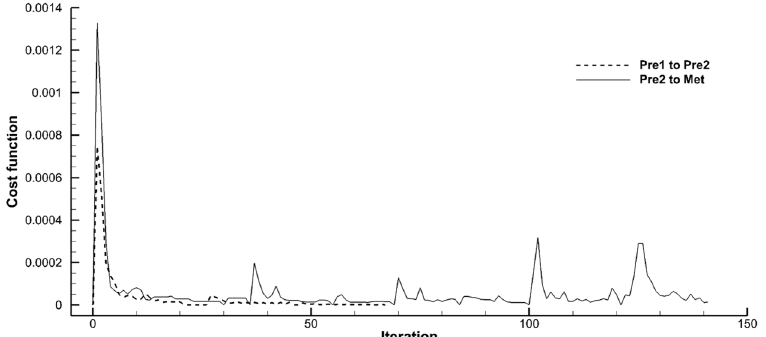
Fig 7. Convergence of cost function during image registration of pre-metastatic and metastatic pairs of a sarcomapatient (Group 3) shown in Fig 4. “Pre1 to Pre2” and “Pre2 to Met” denote for pre-metastatic pair and metastatic pair,